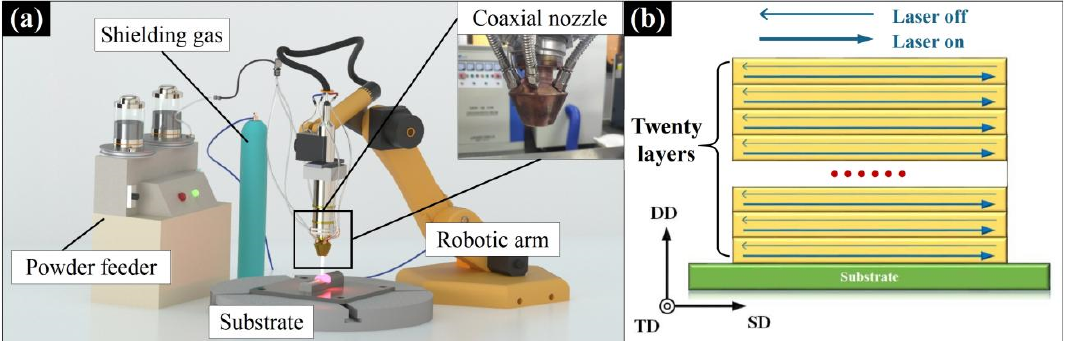
Figure 2. ( a ) Schematic diagram of the LMD equipment; ( b ) schematic diagram of the scanning strategy. SD (laser scanning direction), DD (deposition direction), TD (transverse direction).